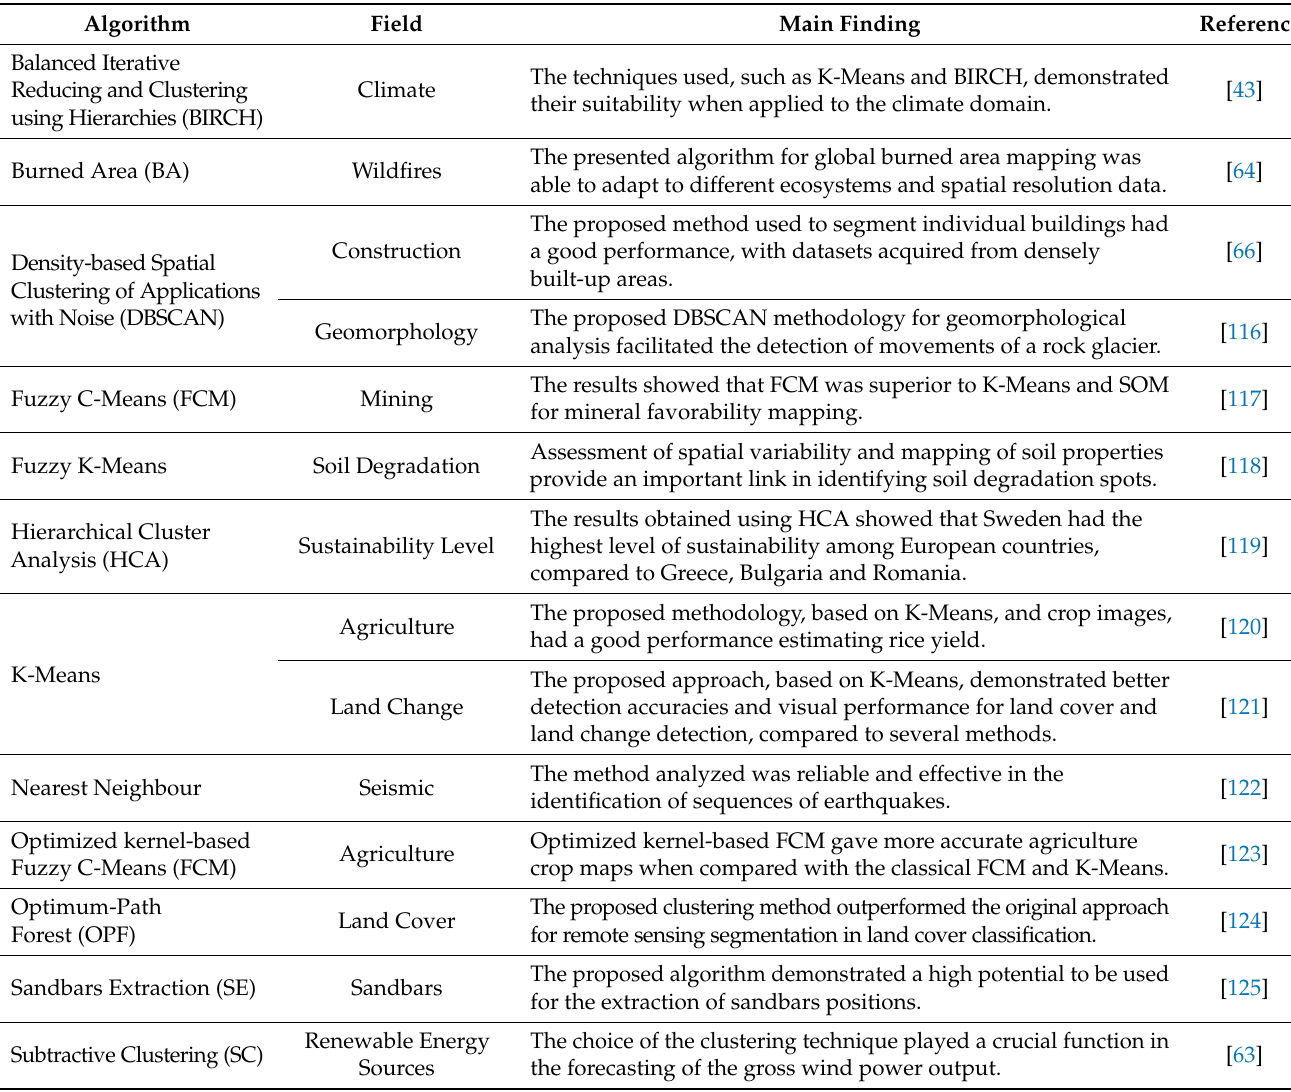
Table 3. Examples of clustering algorithms using EO